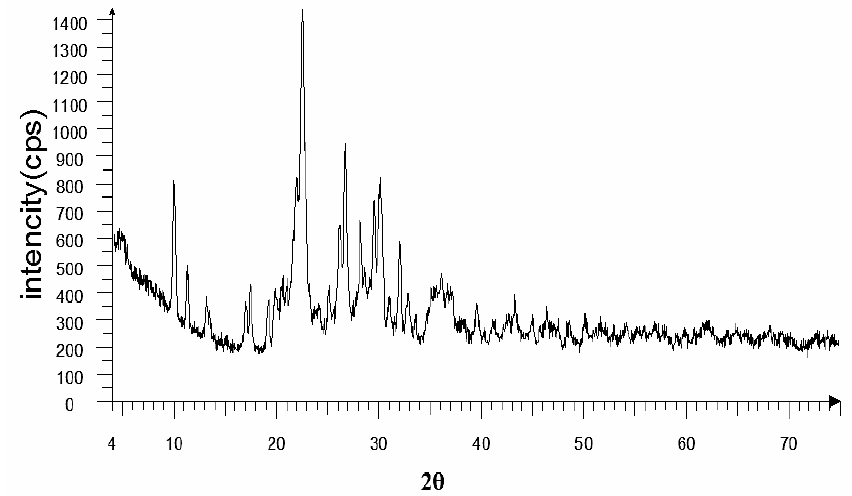
Fig. 3. XRD spectrum of zeolite type of clinoptilolite